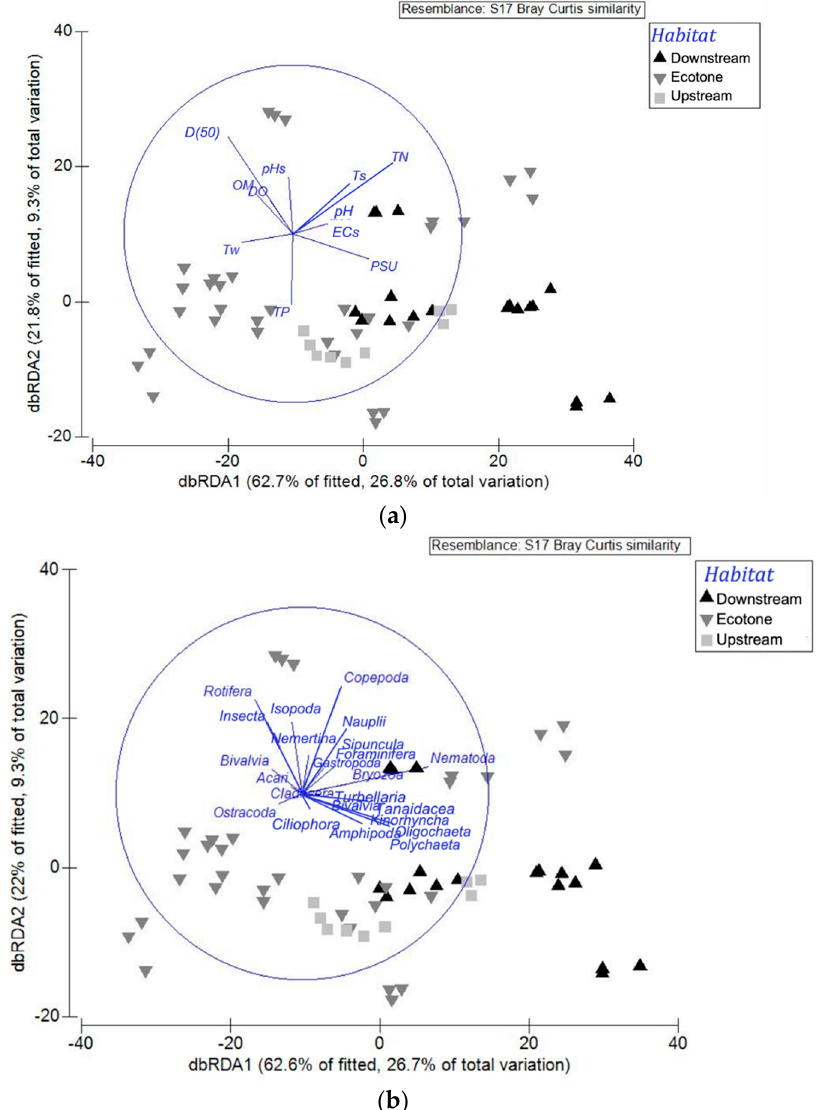
Figure 7. Distance − based redundancy analysis (dbRDA) of meiofaunal community responses to environmental variations showing ( a ) vector overlays of predictor variables and ( b ) vector overlays of species responses. The graph shows the effect of environmental variables on meiofauna community structure based on Spearman’s rank